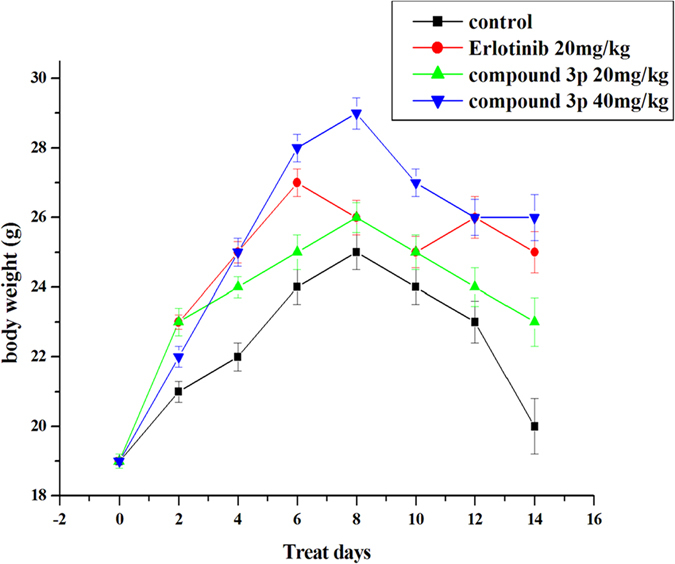
The mice weight was examined every other day.